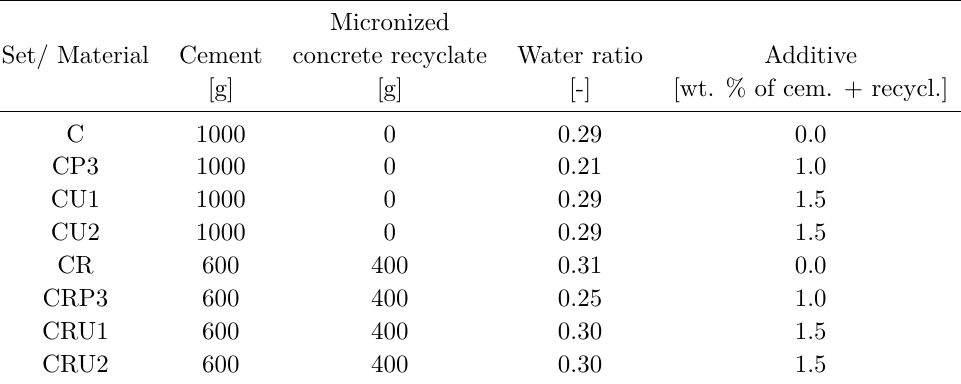
Table 2. Composition of the